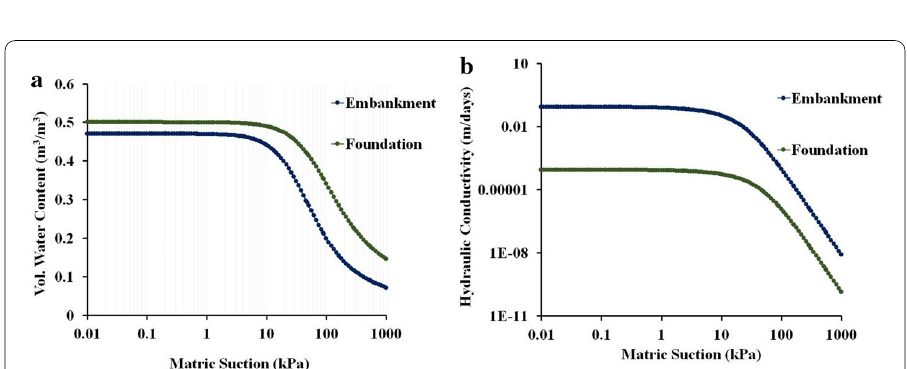
Fig. 6 Hydraulic characteristics of materials for earthen dam and foundation a Volumetric water content function b Hydraulic conductivity